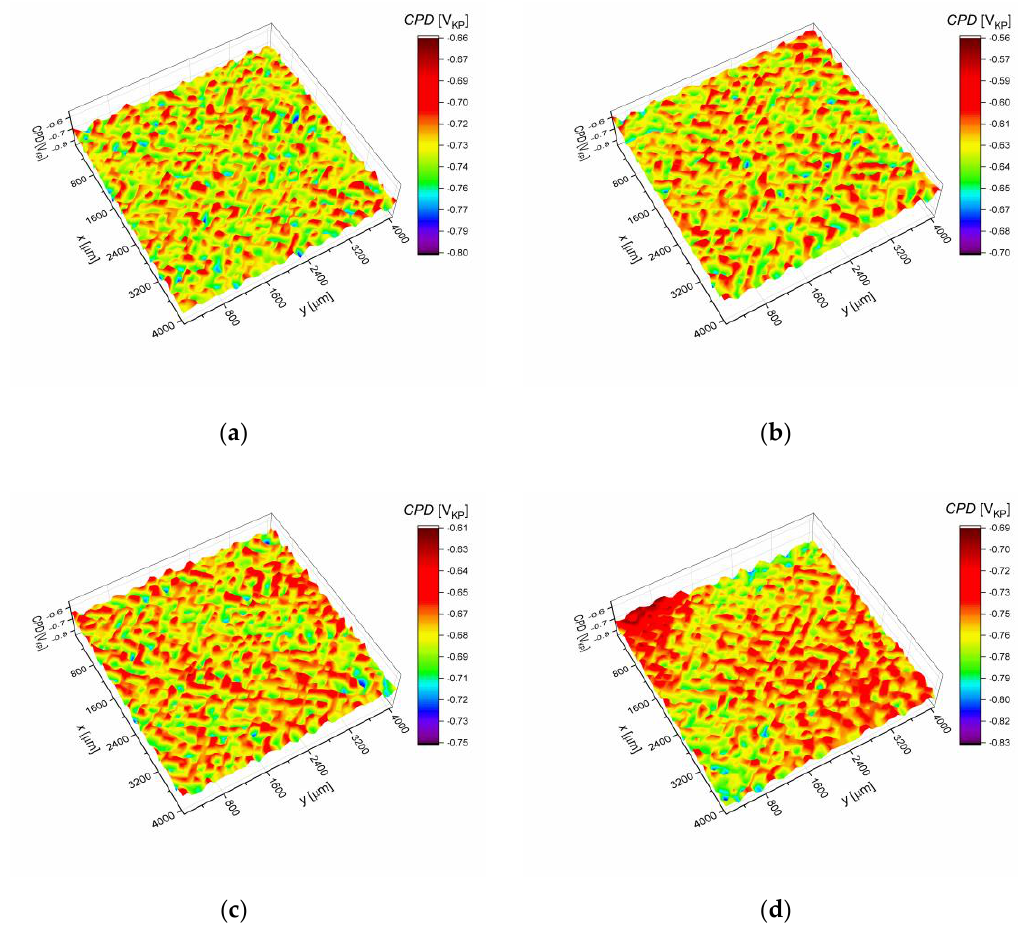
Figure 7. Contact potential difference ( CPD ) maps for the AISI 1010 steel electrodes immersed in sulfolane at 25 ( a ), 95 ( b ), 180 ( c ), and 230 C ( d ); V KP is the voltage measured versus Kelvin probe.